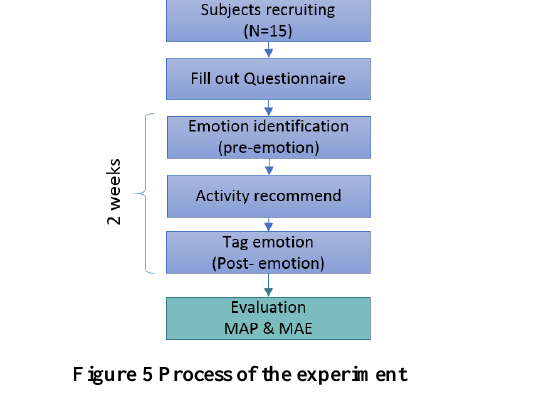
Figure 7 Mean Average Position ( MAP )